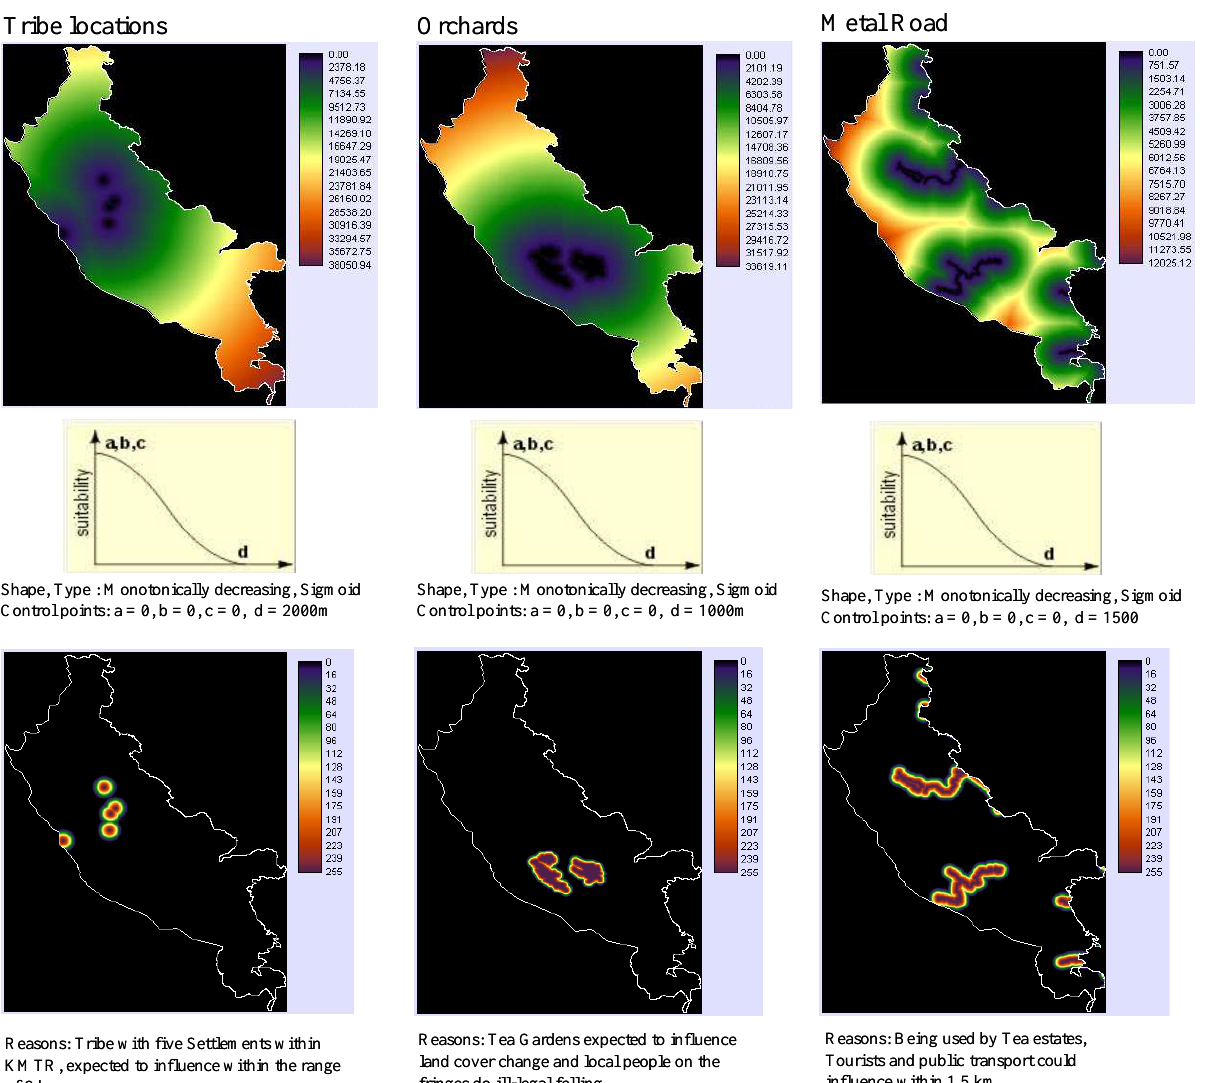
Figure 5. (c) List of potential spatial drivers (locations of tribe, orchards, metal road) generated using multi-criteria decision support to generate suitability image for the evergreen forest change modelling of KMTR, South Western Ghats, Tamil Nadu,